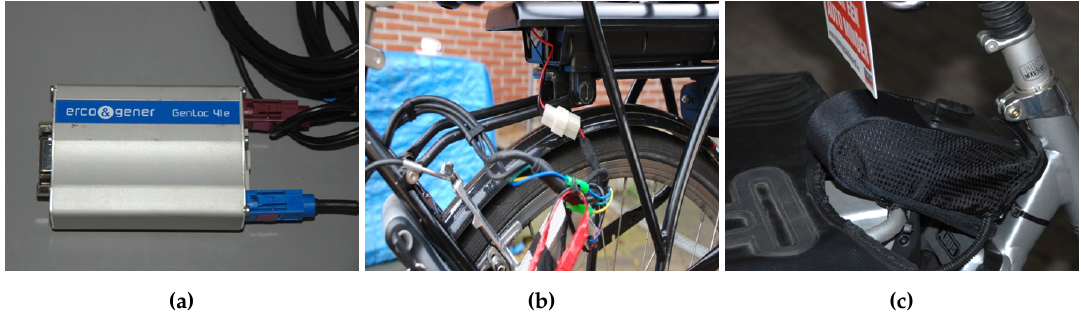
Figure 1. Tracking device set-up ( a ) GPS logger GenLoc41e. ( b ) battery connections. ( c ) installed